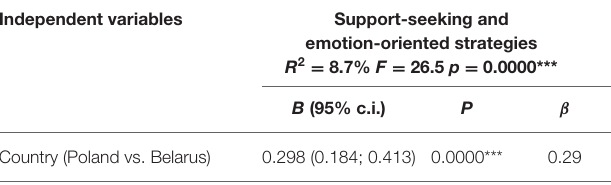
TABLE 11 | Use of support-seeking and emotion-oriented strategies for coping with stress by country. Independent